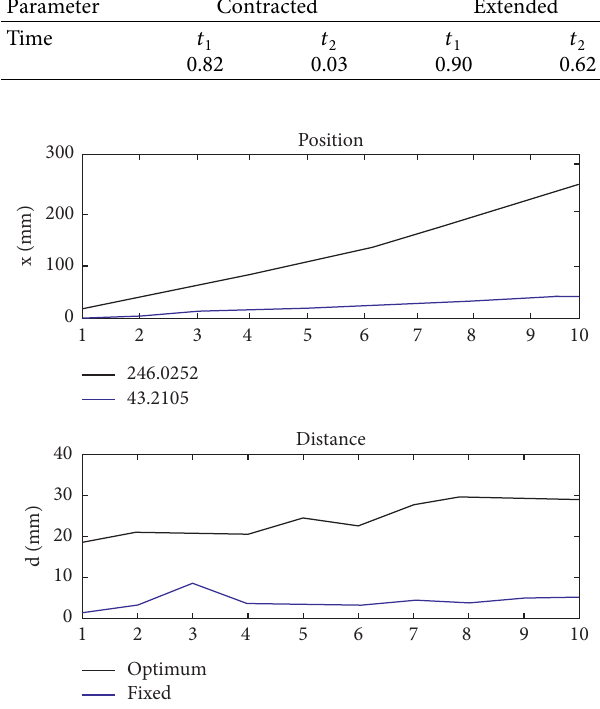
Figure 18: Comparative graph, fixed values (blue) versus optimal parameters